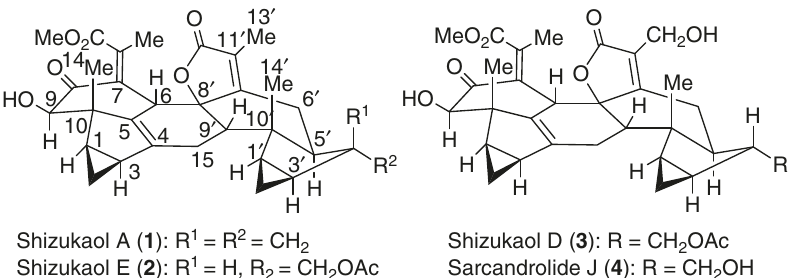
Fig. 1 Structures of dimeric lindenane-type representives. Shizukaol family possesses a common heptacyclic framework with >10 contiguous stereocenters